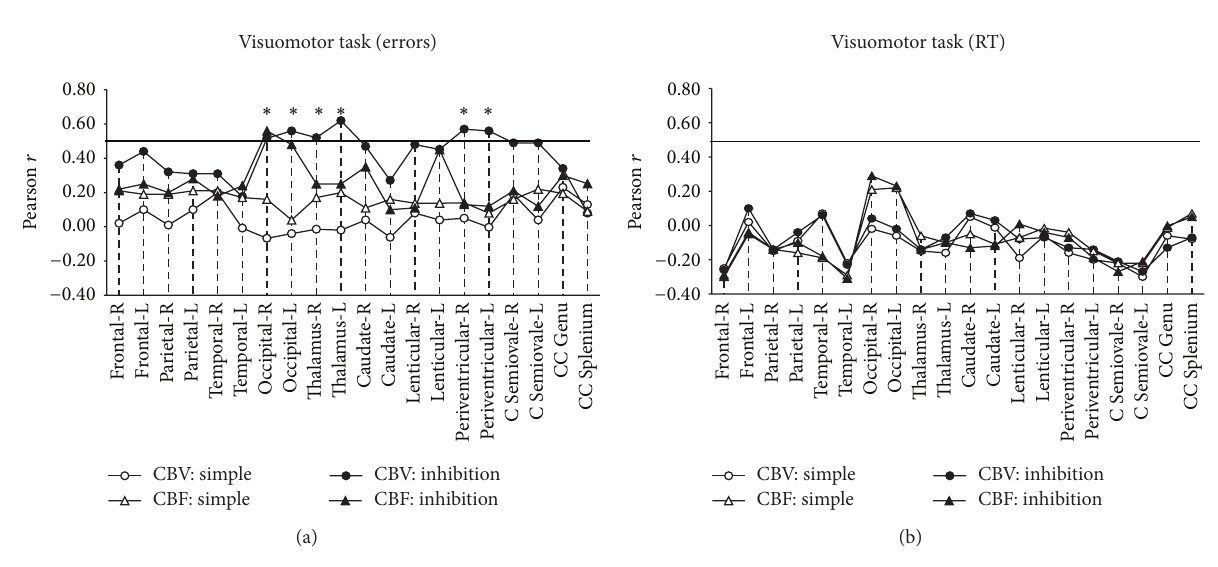
Figure 1: Correlation between performance accuracy and RT during the visuomotor learning task and CBV/CBF values for CIS patients. Zero-order Pearson correlation coefficients between performance accuracy (a) and RT (b) during the visuomotor learning task and CBF/CBV in 20 ROIs in the left (L) and right (R) hemispheres and the corpus callosum. Coefficients > 0.50 were significant at a Bonferroni-corrected alpha level of .0025 (indicated by horizontal solid lines). Asterisks indicate significant correlations which were also found to be condition specific (based on Fisher’s 𝑧 test for the difference between correlation coefficients in the “simple” and “executive”